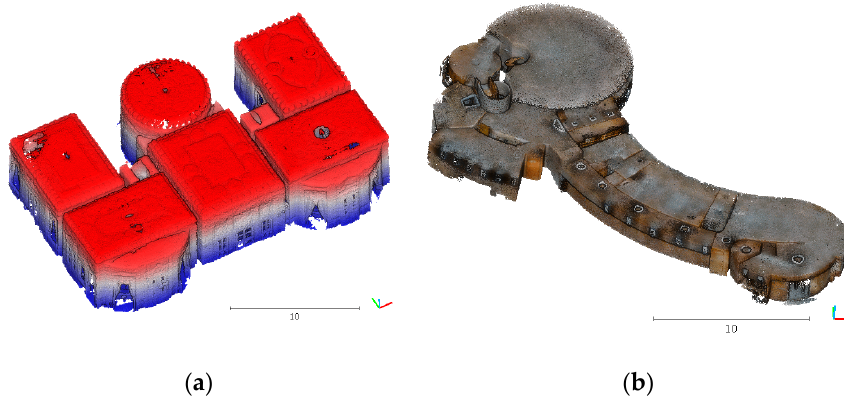
Figure 11. Test sites: original point clouds of a real-world dataset-1 ( a ) and dataset-2 ( b ).